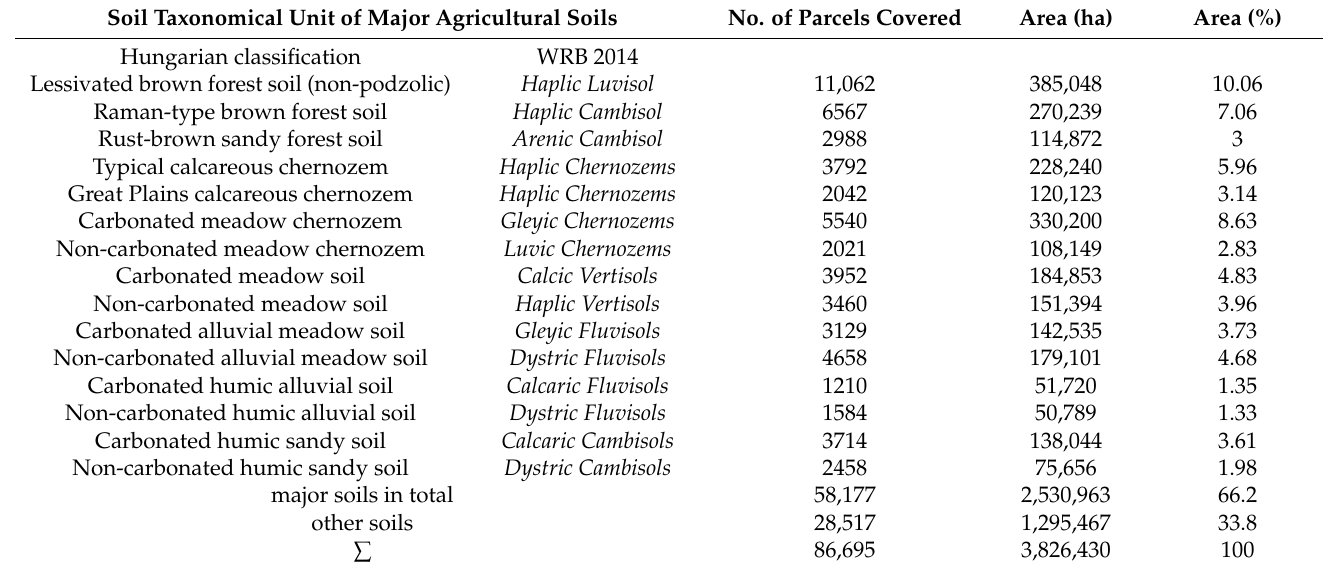
Table 1. Main features of the AIIR dataset, based on Hungarian [32] and World Reference Base for Soil Resources [33]